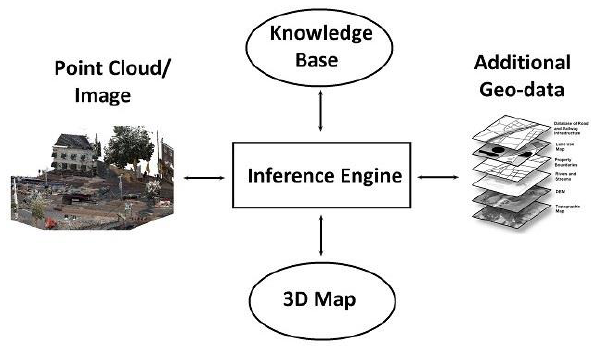
Figure 4. Schematic overview of a knowledge-based system for 3D mapping from point clouds